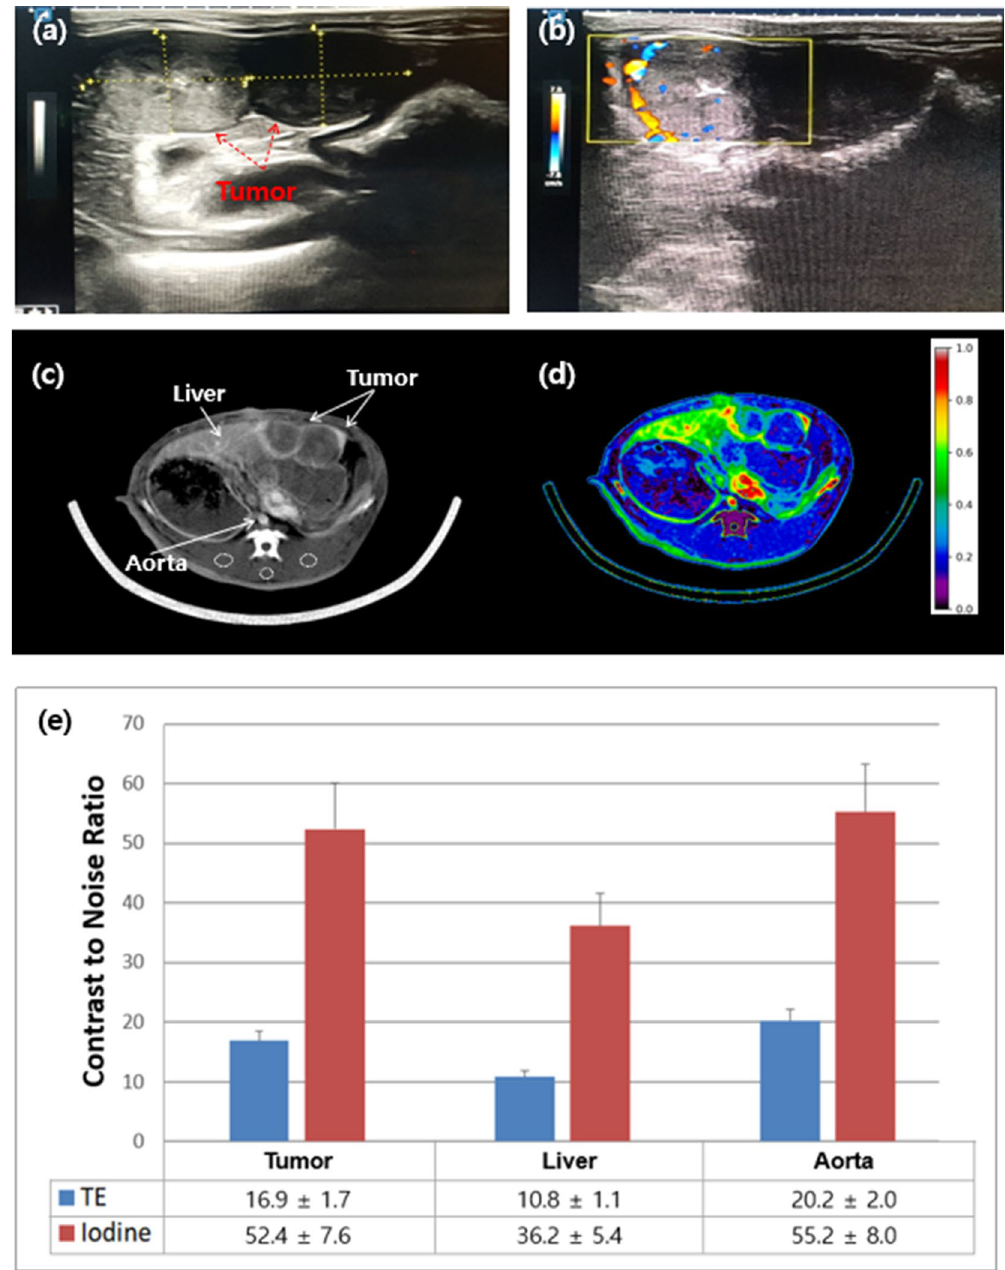
Figure 7. Rabbit with VX2 tumors located in the anterior part of the liver presented as ( a ) two-dimensional and ( b ) three-dimensional flow images produced via Doppler ultrasonography. ( c ) Contrast-enhanced axial image acquired at the total energy range and ( d ) iodine map image of the rabbit liver in the PCD CT system. The dotted circles are back muscles. 30–100 keV, 10 mAs, slice thickness = 2.5 mm, WW/WL [450/100]. ( e ) Contrast-to-noise ratio (mean ± SD) of the PCD CT system for the tumor, liver, and aorta in the total energy range (TE, 30–140 keV) of a rabbit acquired at an energy level in the range of 30–140 keV and the iodine